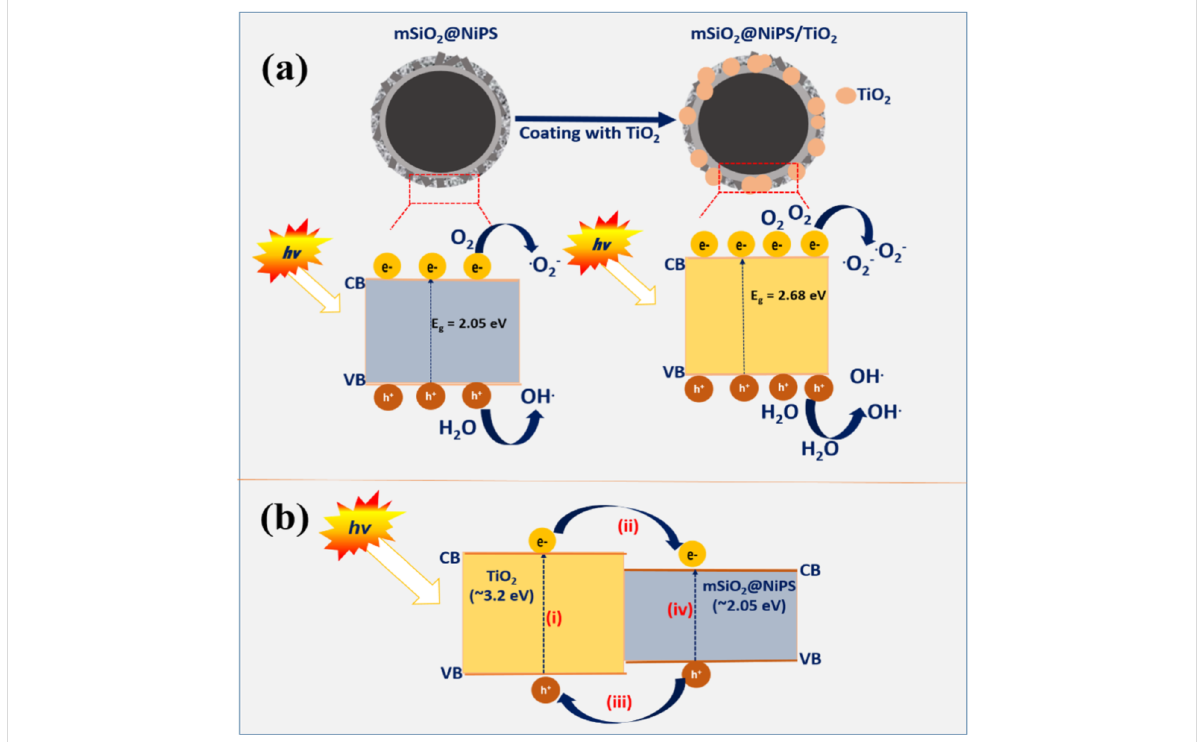
Figure 6: Proposed charge-transfer mechanism in mSiO 2 @NiPS and mSiO 2 @NiPS/TiO 2 nanostructures under UV light illumination.